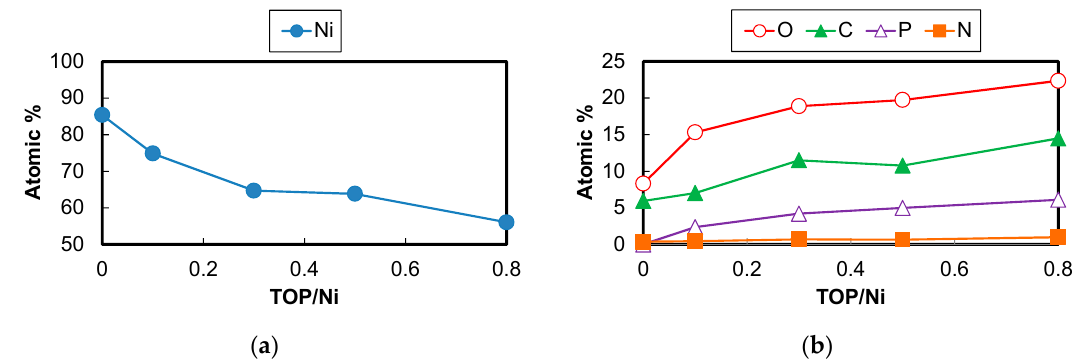
Figure 8. ( a ) Ni atomic percentage and ( b ) O, C, P, and N atomic percentages for the Ni nanoparticles at the TOP/Ni ratios from 0–0.8.